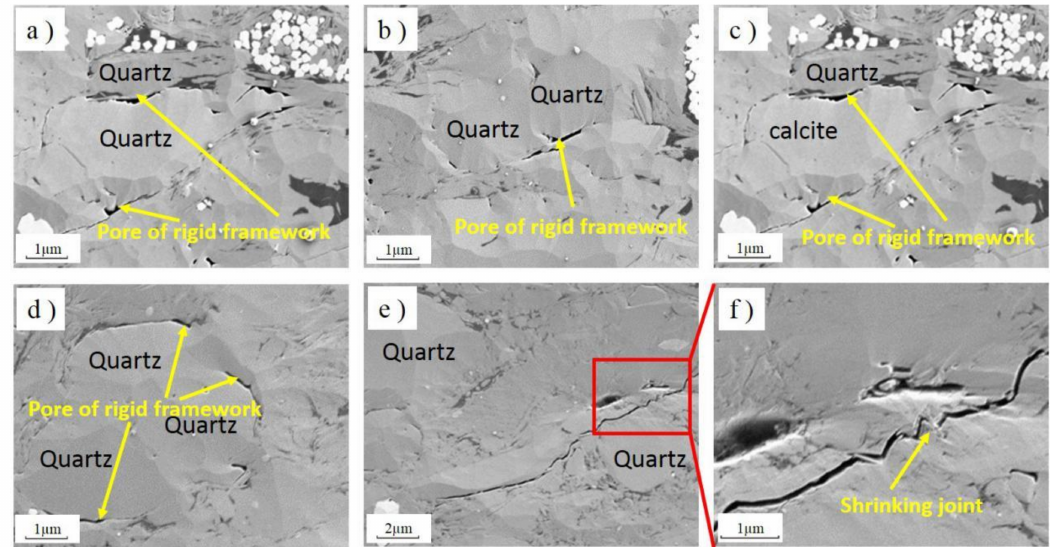
Figure 7. The FIB-SEM 2D images of pores of rigid framework: Pores are marked by the yellow arrows. ( a – c ) are #1, #2 and #3 samples of the lower Cambrian shale. ( d – f ) are #10 and #13 samples of the lower Silurian shale. In ( e , f ), the crack is a shrinkage crack and should not exist under formation conditions (#12).